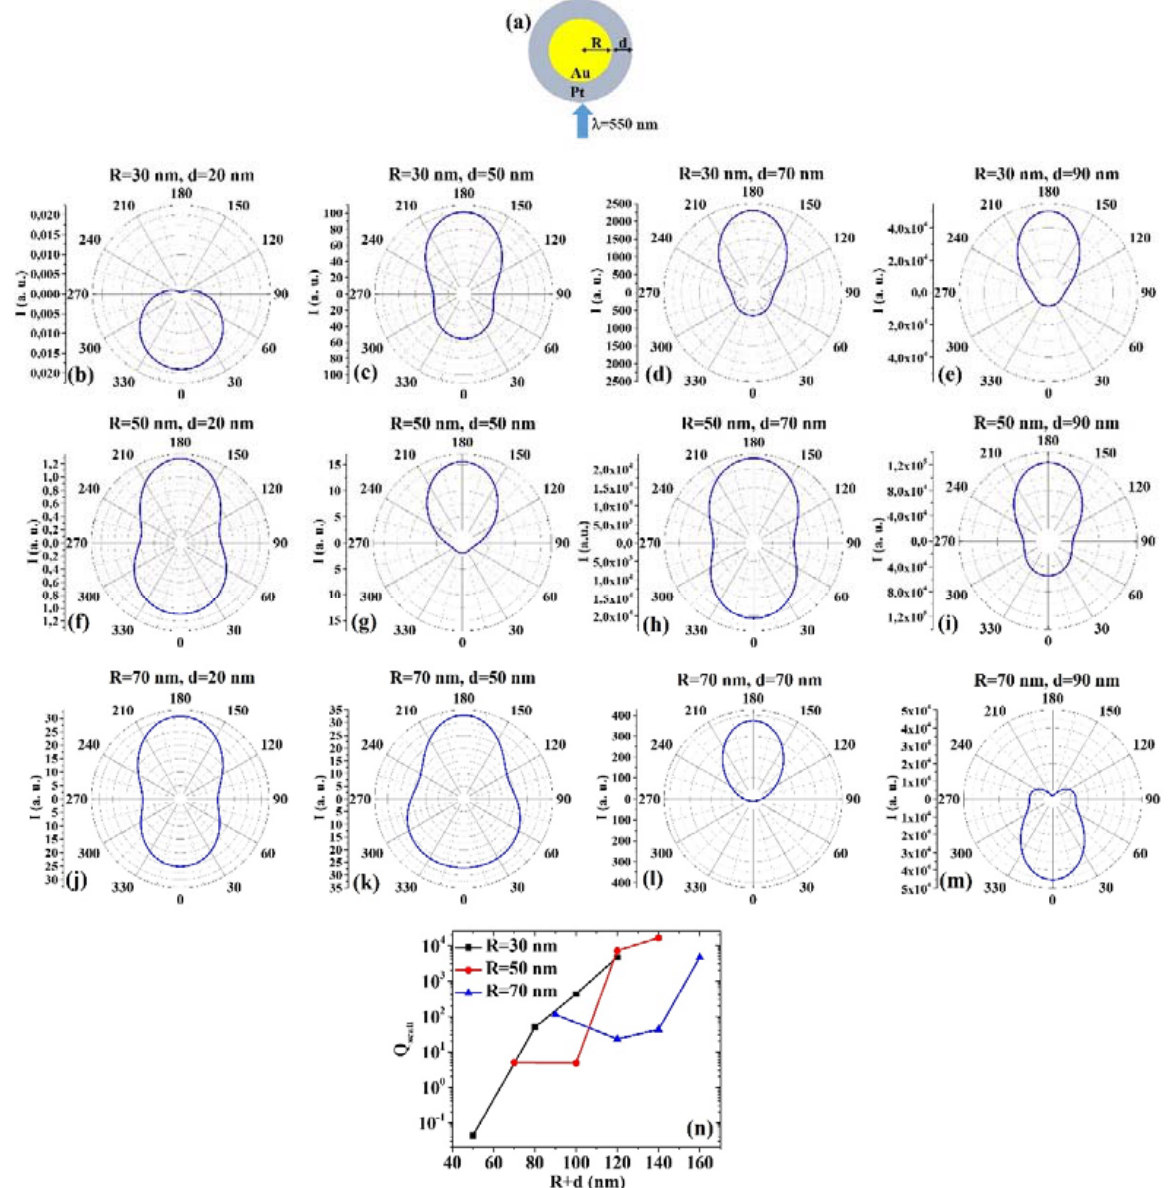
Figure 7. ( a ) Scheme of the structure of the simulated Au/Pt core/shell spherical particle with core radius R and shell width d and electromagnetic radiation of wavelength λ = 550 nm impinging on the particle from 0°. ( b – m ) Calculated polar diagrams for the intensity of the scattered light from the Au/Pt core/shell spherical particle changing the Au core radius R and the Pt shell width: (b–e) R = 30 nm and d = 20 nm ( b ), d = 50 nm ( c ), d = 70 nm ( d ), d = 90 nm ( e ); ( f – i ) R = 50 nm and d = 20 nm ( f ), d = 50 nm ( g ), d = 70 nm ( h ), d = 90 nm ( i ); ( j – m ) R = 70 nm and d = 20 nm ( j ), d = 50 nm ( k ), d = 70 nm ( l ), d = 90 nm ( m ). ( n ) Calculated scattering efficiency for the light (wavelength λ = 550 nm) scattering process of the Au/Pt spherical particle fixing the Au core diameter (R = 30 nm black dots, R = 50 nm red dots, R = 70 nm blue dots) and increasing the Pt shell width d from 20 nm to 90 nm.